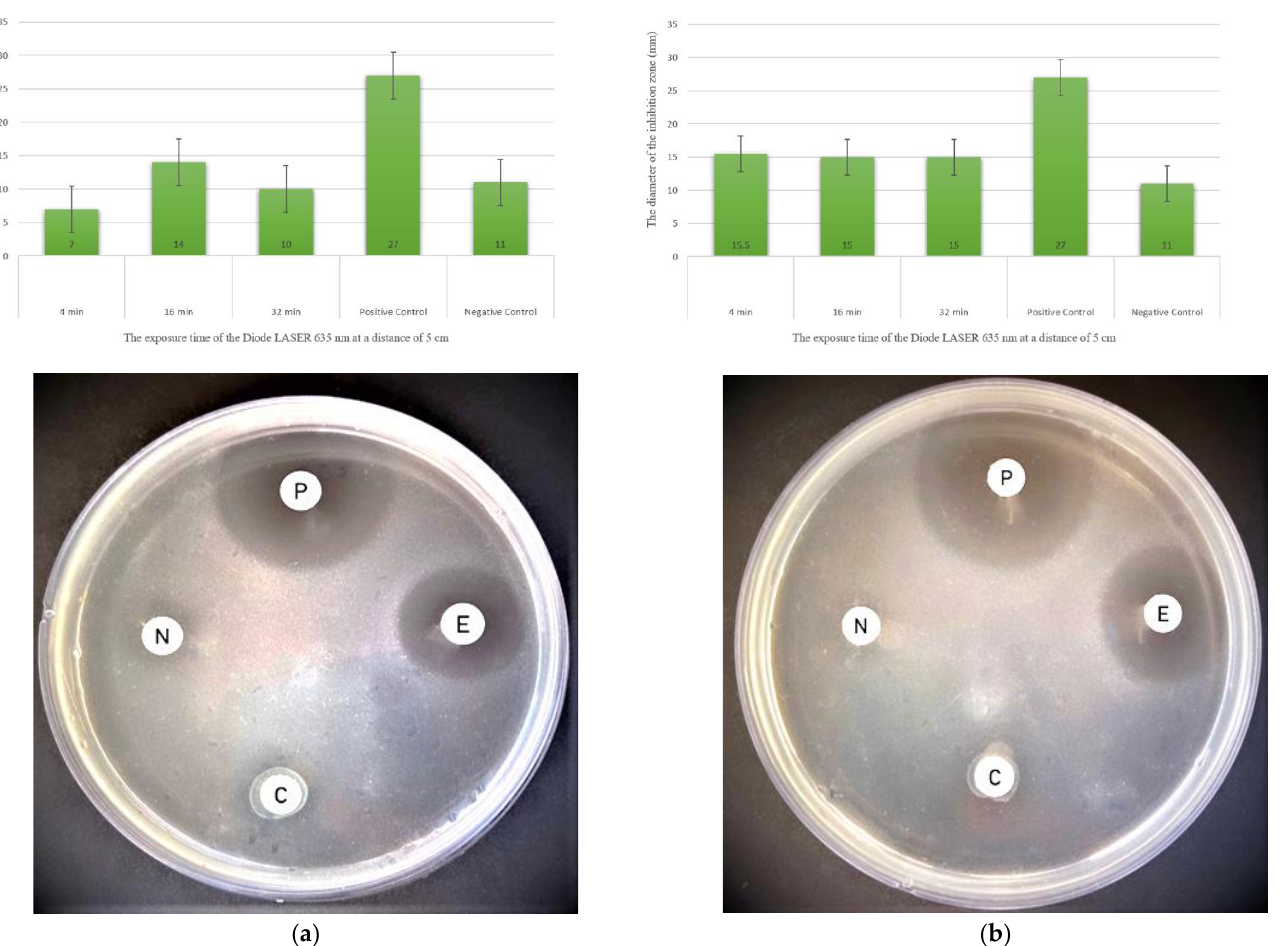
Figure 4. Effect of laser treatment by different exposure times at a distance of 5 cm on Thermolep- tolyngbya sp. extracts derived from cyanobacterial biomass pre-exposed to laser and extracts directly exposed to laser against Staphylococcus aureus . (P) — positive control; (N) — negative control; (C) — an extract derived from cyanobacterial biomass pre-exposed to laser; (E) — an extract directly exposed to laser. ( a ) An agar plate showing the highest inhibition zone of extracts derived from biomass pre-exposed to laser for 16 min. ( b ) An agar plate showing highest inhibition zone of extracts directly exposed to laser for 4 min.